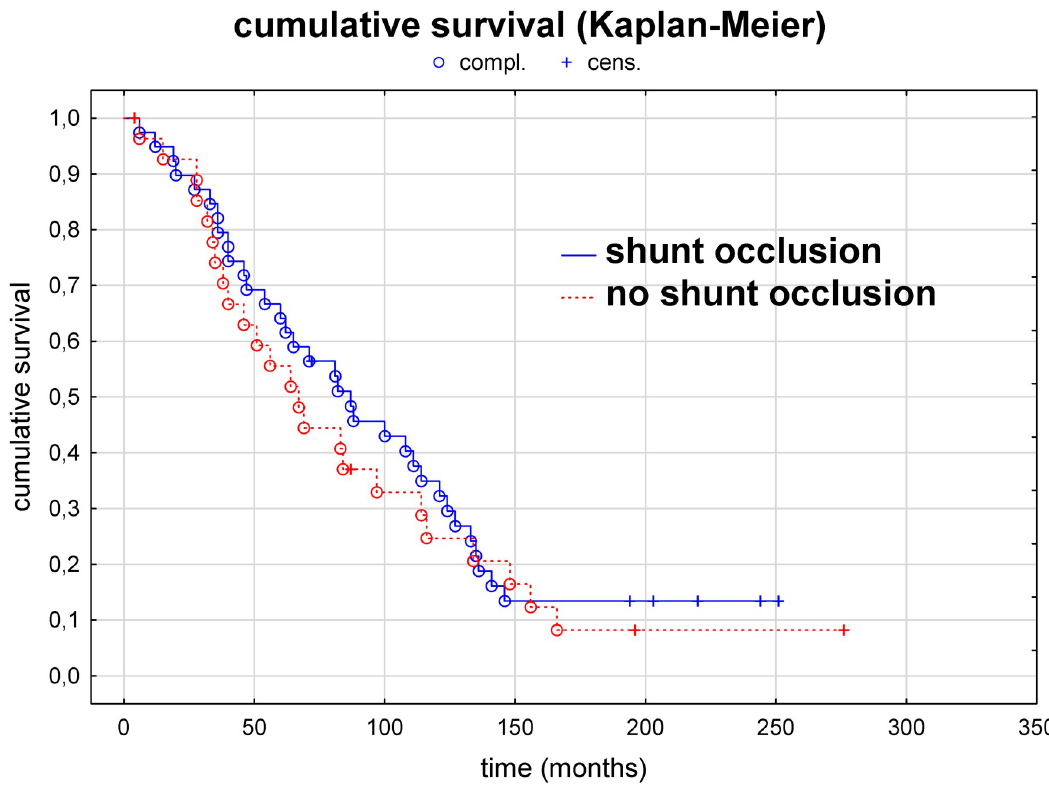
Fig 3. Survival analysis (Kaplan–Meier estimate and log-rank test) of patients with versus those without early shunt occlusion within 2 years. No significant difference is observed between the 2 groups ( P = 0.63).